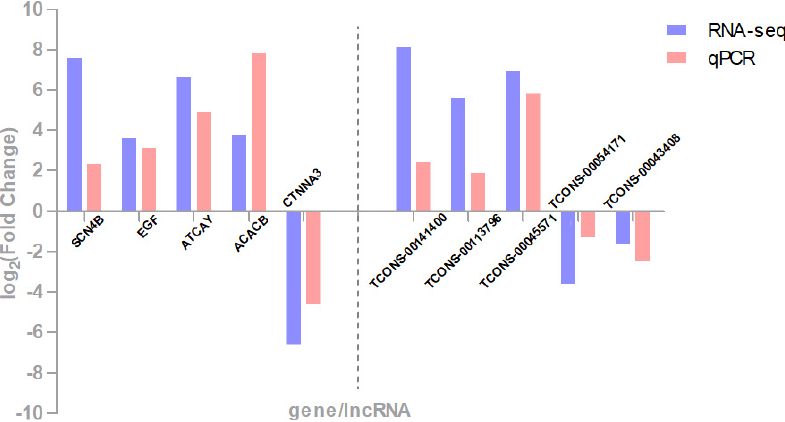
Figure 8. Validation of DEGs and DELs through qRT-PCR.